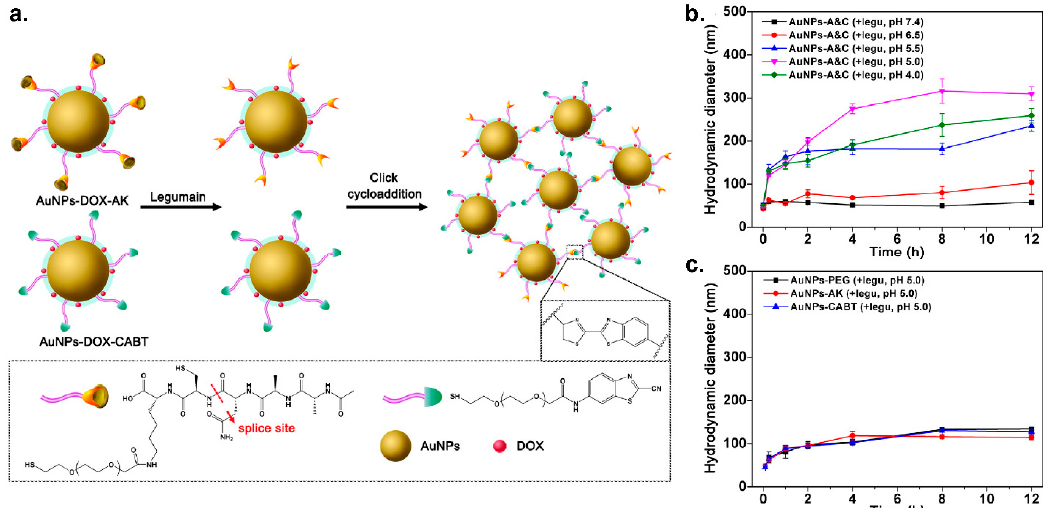
Figure 7. ( a ) Schematic representation of the legumain-triggered AuNP aggregation and composition of AuNPs functionalized with peptides (Ala-Ala-Asn-Cys-Lys) (AuNPs-AK) and AuNPs grafted with 2-cyano-6-amino-benzothiazole (AuNPs-CABT). ( b ) The proteolytic capacity of legumain is pH dependent. As a result, AuNP aggregation triggered by legumain varied at different pH values and the size increase was the highest at pH 5.0, as confirmed by DLS measurement. ( c ) AuNPs functionalized with PEG, AuNPs-AK only or AuNPs-CABT only was used as controls. DLS data showed that no aggregation was observed when treated with legumain at pH 5.0. (Adapted with permission from Reference [122], Published by American Chemical Society, 2016).